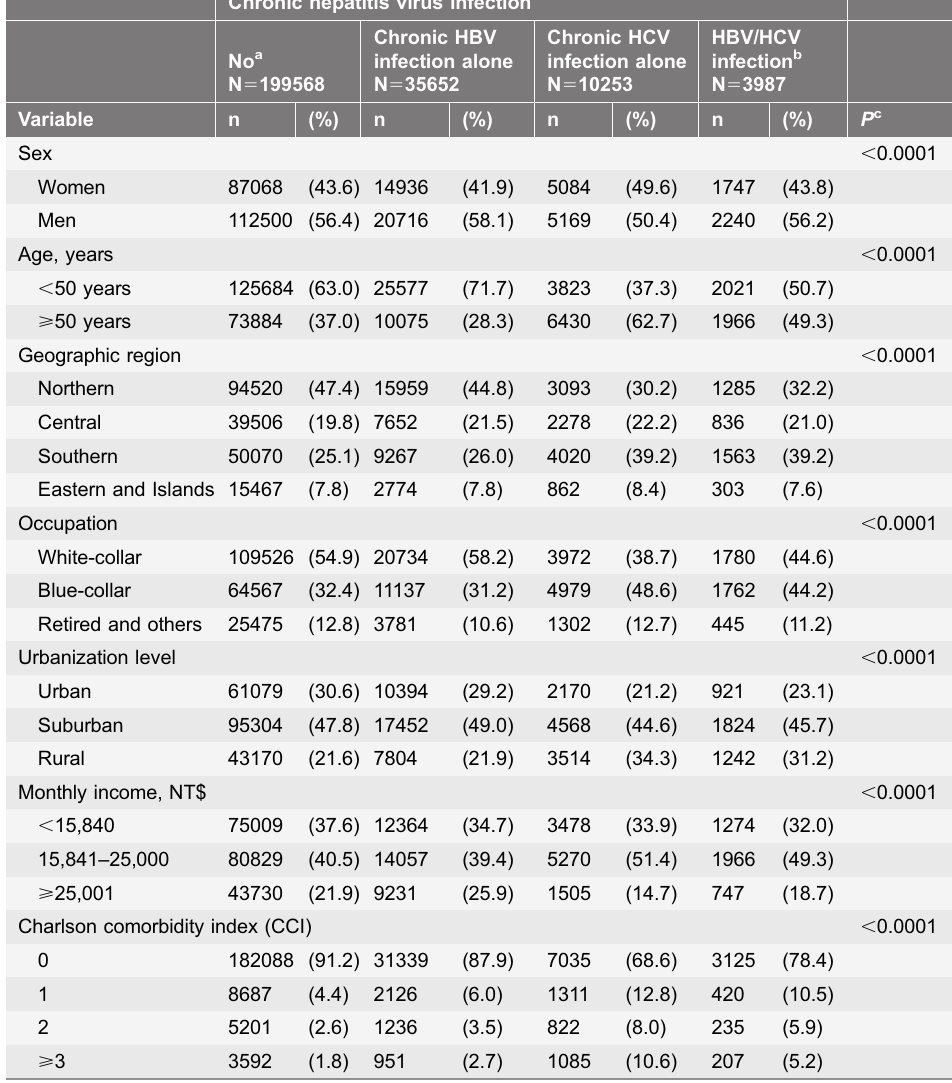
Table 1. Baseline characteristics of the chronic hepatitis virus infection cohorts identified in